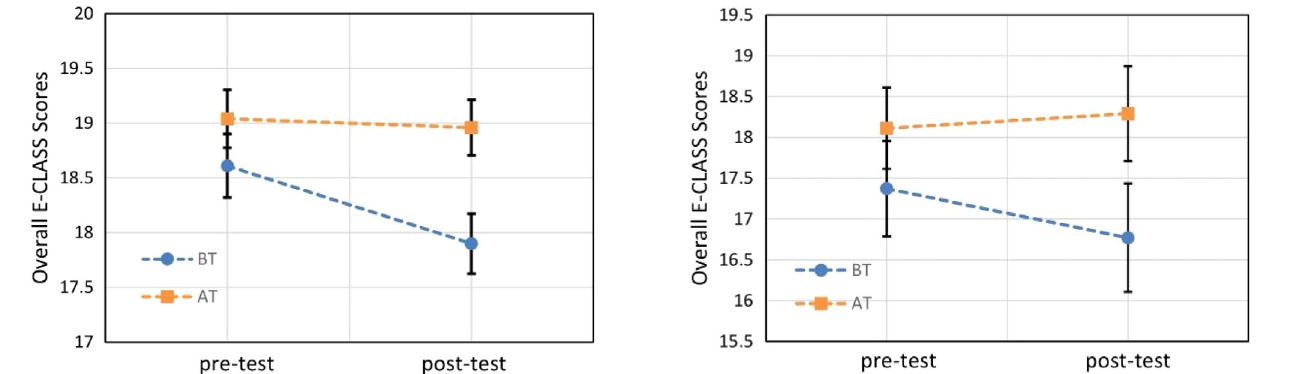
FIG. 1. Comparison of the average overall E-CLASS scores between the BT (blue, N ¼ 1449 ) and AT (orange, N ¼ 1723 ) offerings of the course. Error bars are 95% confidence intervals and dashed lines are for guidance.